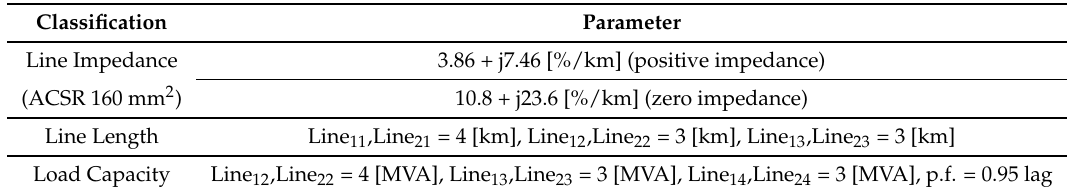
Table 1. Parameters for the system.